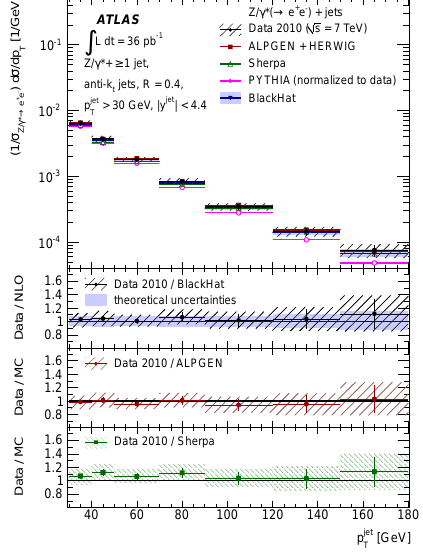
µ + µ − ) + jets production Fig. 4. Dijet cross section in Z / γ ∗ ( → malized by Drell-Yan cross section as a function of the azimuthal separation of the two leading jets.